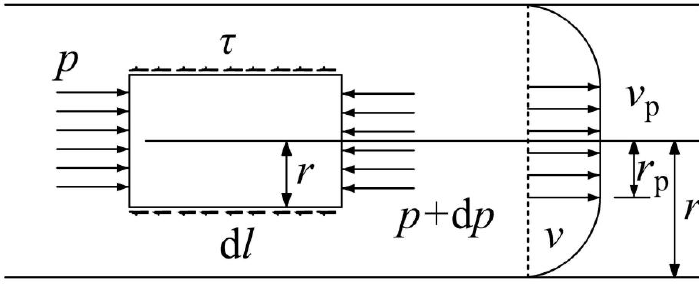
Figure 2. Force analysis of grout in the capillary channel.